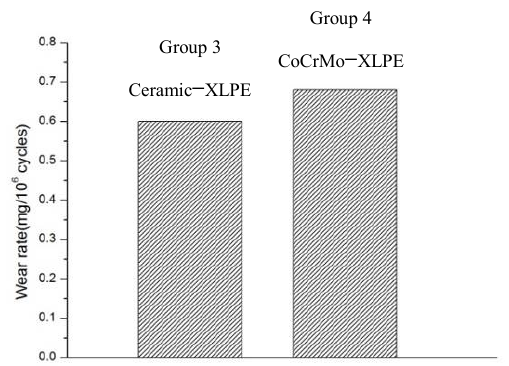
Figure 4. Wear rate for Group 3 and Group 4.